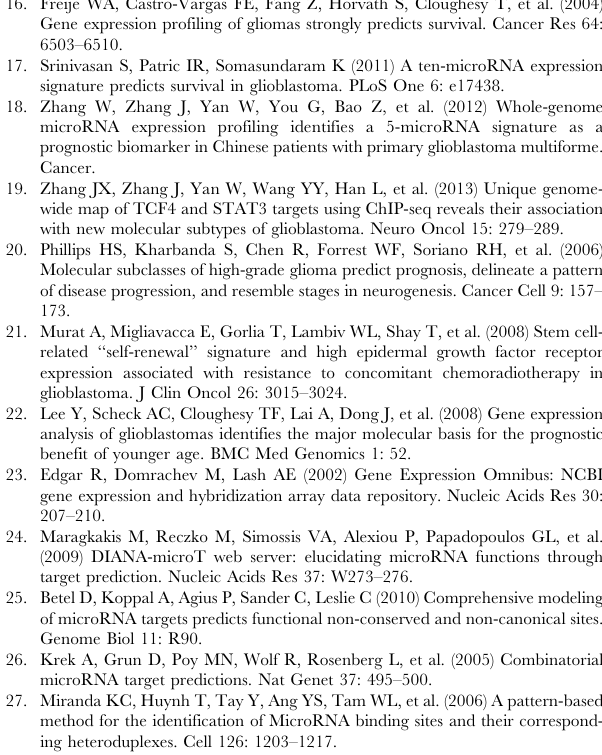
colored red belonged to the 9-gene signature (see Figure 5). (PDF) Figure S8 The 26-gene signature predicts the clinical outcome of glioma samples using nearest centroid classification method. ( A ). TCGA dataset and the study of ( B ) Freije et al., ( C ) Phillips et al., ( D ) Lee et al., and ( E ) Murat et al. (PDF) Figure S9 The 26-gene signature from moduleS3 pre- dicts the clinical outcome of temozolomide-treated samples from TCGA. Table S1 The biological pathways enriched by glioma survival related genes (survival related miRNA’s target genes). Table S2 The detailed information of glioma survival related pathways. Table S3 The P-value performance of each miRNA (gene) from moduleS3 in the testing set. Table S4 Univariable and multivariable cox regression analysis of our expression